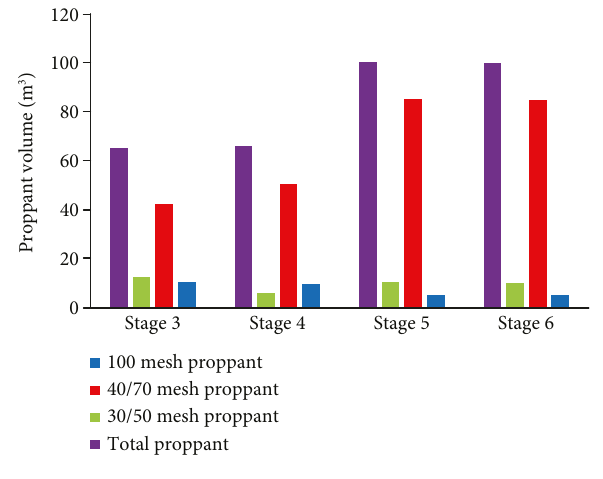
Figure 15: Proppant parameters of initial fracturing job.